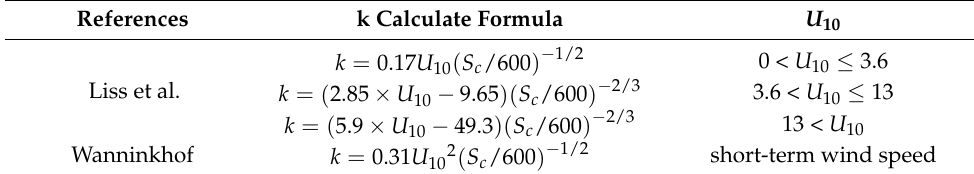
Table 1. Calculation formula related to the K